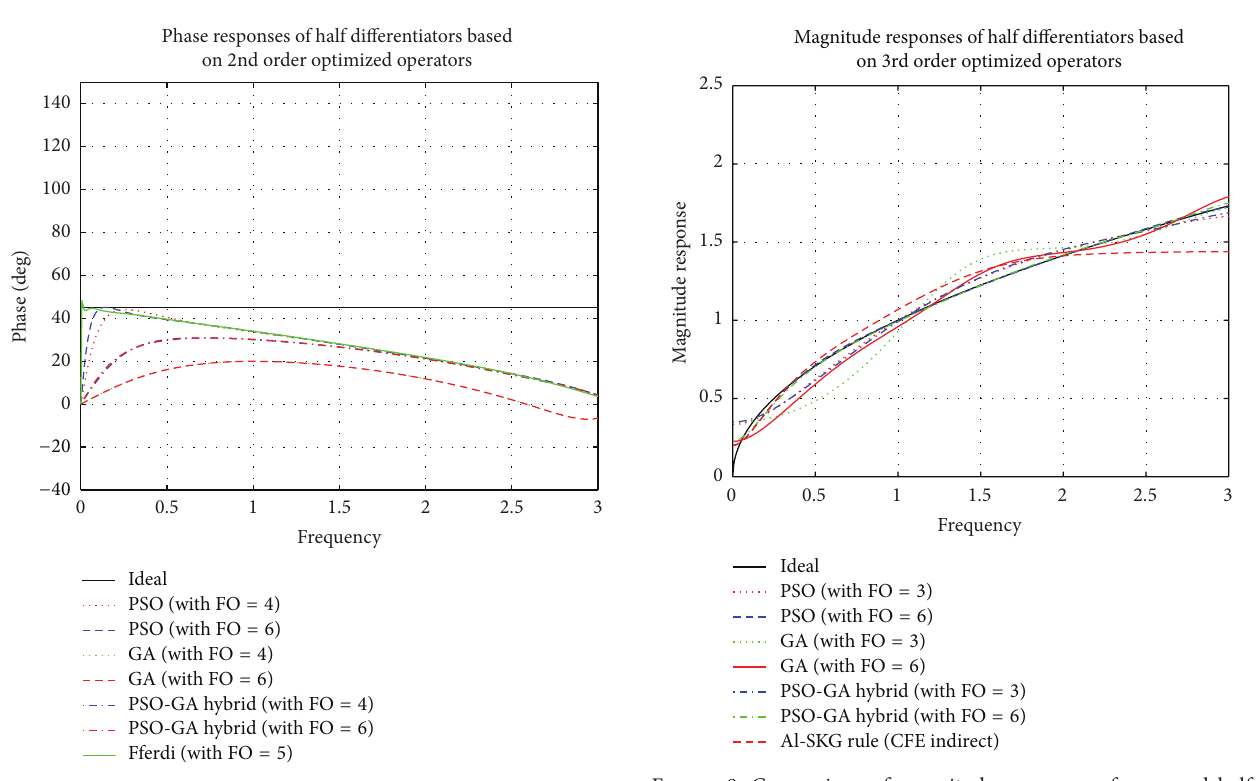
Figure 8: Comparison of phase responses of proposed half differ- entiators based on 2nd order optimized differential operators.